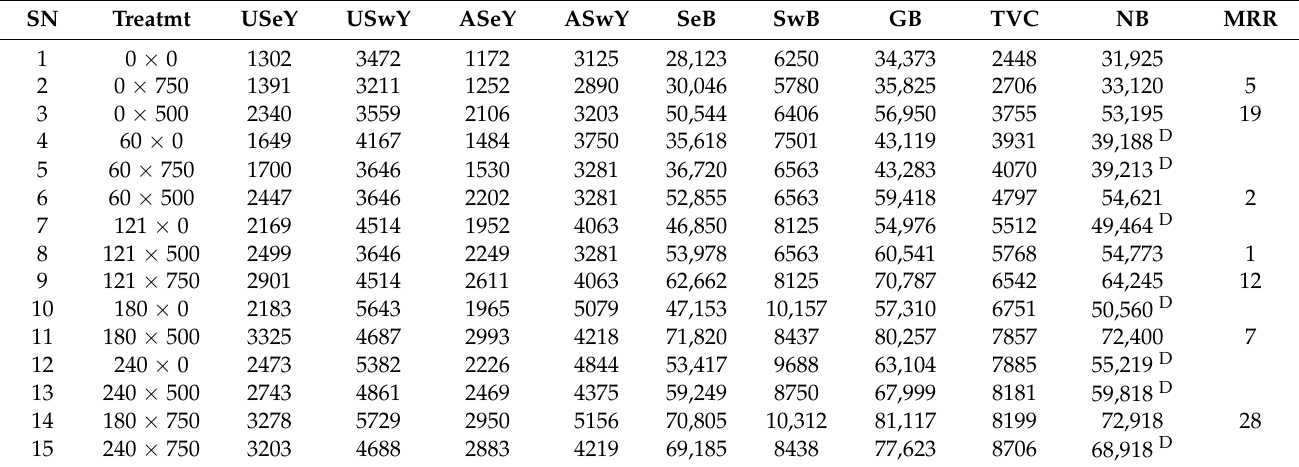
Table 12. An economic analysis of the